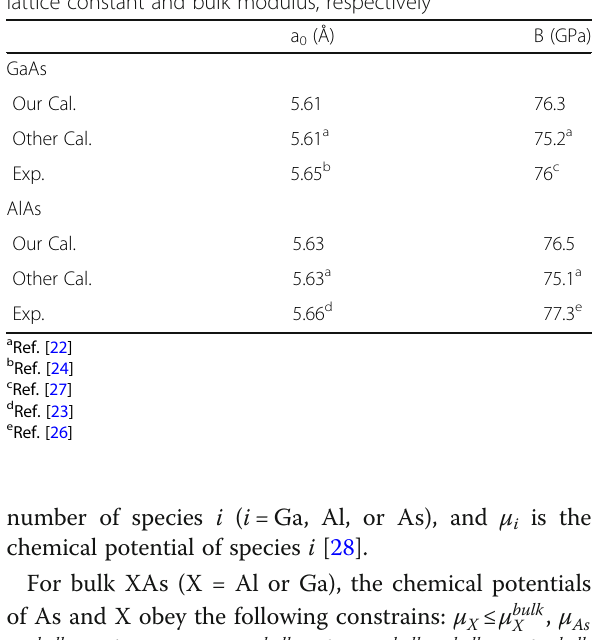
Table 1 The calculated and experimental ground state properties of bulk GaAs and AlAs. The a 0 and B refer to the lattice constant and bulk modulus, respectively GaAs Our Cal.